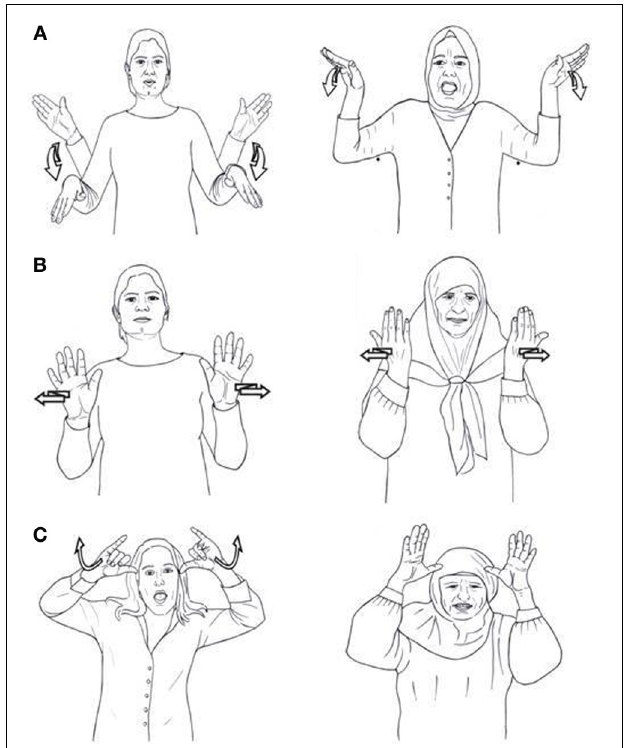
FIGURE 1 | (A) Two signs distinguished by handshape: DEPRIVE and PROFIT . (B) Two signs distinguished by location: WELL - BEING and CURIOSITY . (C) Two signs distinguished by movement: ESCAPE and BETRAY .